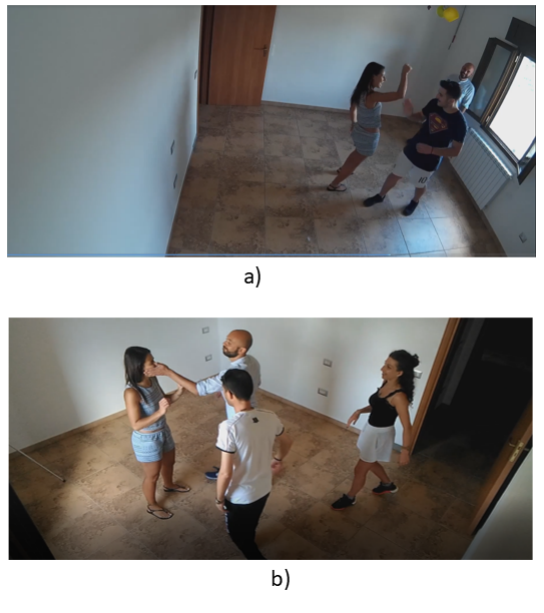
Figure 7. AIRTLab Dataset: ( a ) nonviolent, ( b )